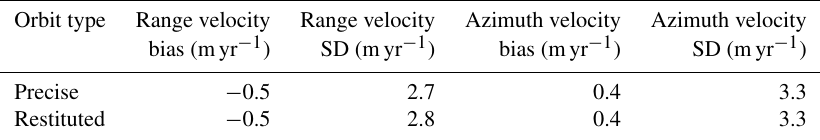
Figure 4. The effect of the culling procedure: example from Hagen Bræ, north Greenland. (a) Overview of the Hagen Bræ area. The flow line is plotted in black, and the grounding line (GL) (from ESA Greenland Ice Sheet CCI) is plotted in red. The ice velocity along the flow line in panel (a) is plotted for all maps since September 2016 in the case of no culling (b) , applying k thr = 3 (c) , and applying k thr = 1 (d) . Table 2. Comparison of precise and restituted orbit files. Range direction is line of sight, and azimuth direction is along the satellite flight